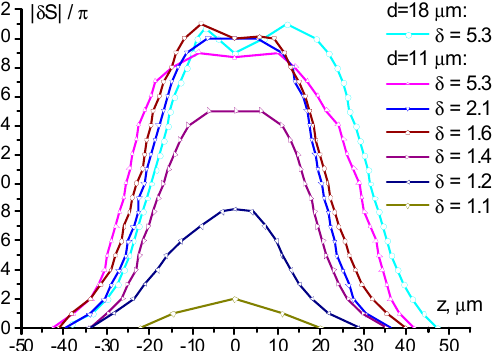
Figure 4. The phase shift reconstructed from the microphotographs shown in Figures 2b–g and 3a. Lines are an eye-guide connecting the experimental points.